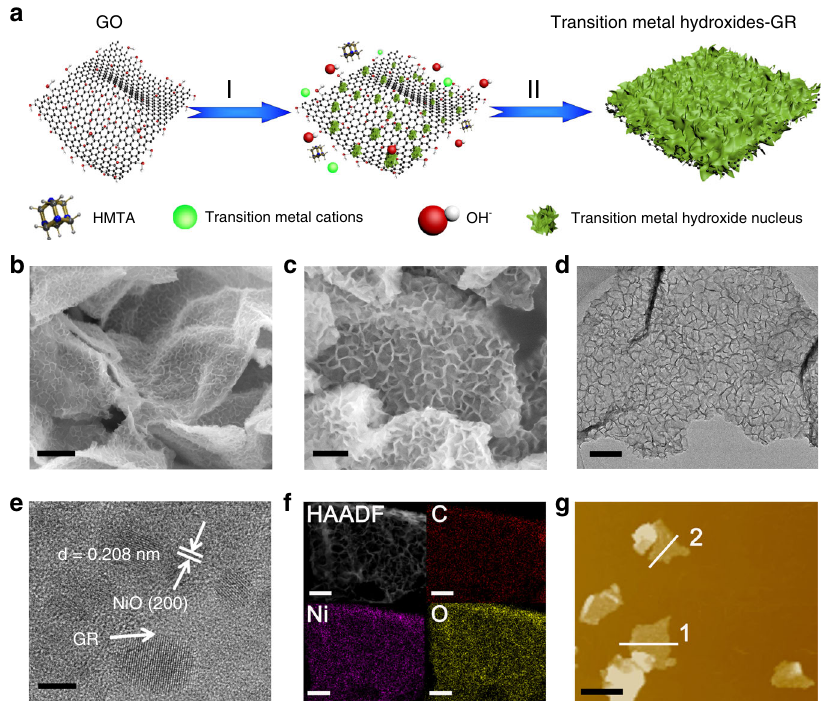
Fig. 1 Synthesis and morphology characterization. a Schematic illustration of synthesis procedure for transition metal hydroxides onto the GR platform. I in situ heterogeneous nucleation, II oriented crystal growth. b , c FESEM images, d TEM image, e HRTEM image, f elemental mapping results, and g AFM image of the Ni(OH) 2 -10%GR. The scale bar are 500 nm in b , 200 nm in c , 100 nm in d , 2 nm in e , 1 µ m in f , 3 µ m in g